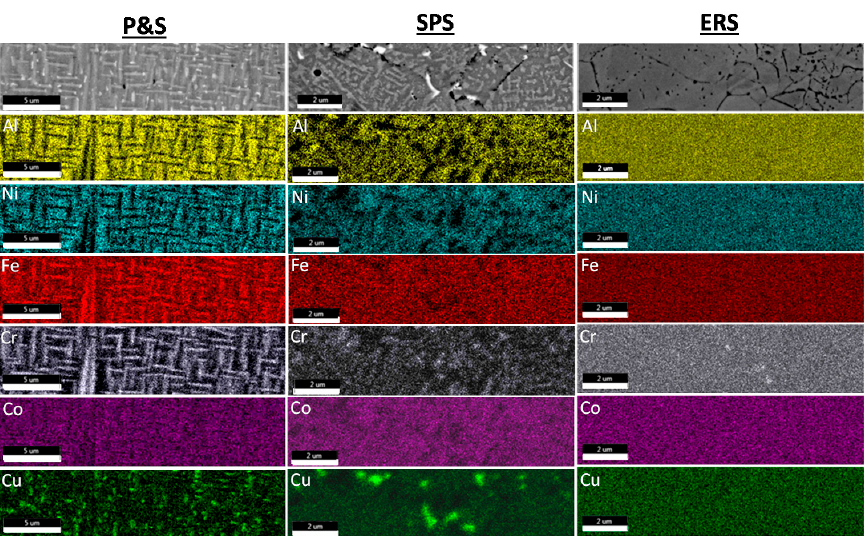
Figure 10. EDS area mapping conducted on FeCrCoNiAl 1.8 Cu 0.5 HEA by sintering methods. Table 3. Compositional and volumetric fraction analysis performed on the phases from mapping tests.